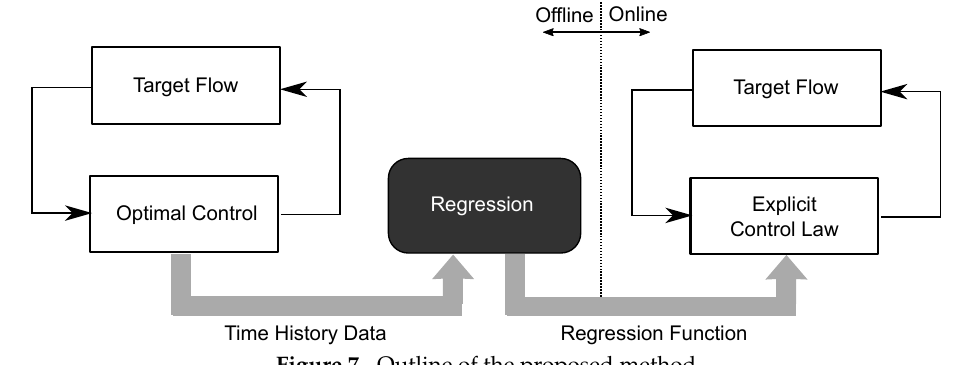
Figure 7. Outline of the proposed method.